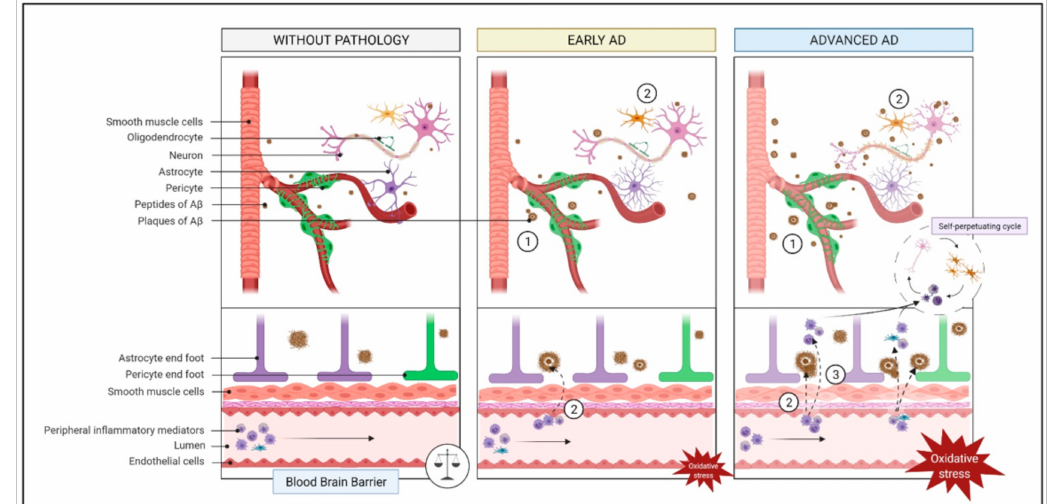
Figure 3. Endothelial function and cerebrovascular insufficiency pathway. In AD brains, the neuroinflammatory response causes an increase in the blood brain barrier (BBB) permeability. Also, the deposition of A β plaques in cerebral vessels (step 1) can augment BBB permeability (step 2), resulting in a release of peripheral inflammatory mediators on the brain, increasing the oxidative stress. This potentiates the self-perpetuating cycle of AD pathogenesis. Abbreviations: A β , amyloid beta; AD, Alzheimer’s